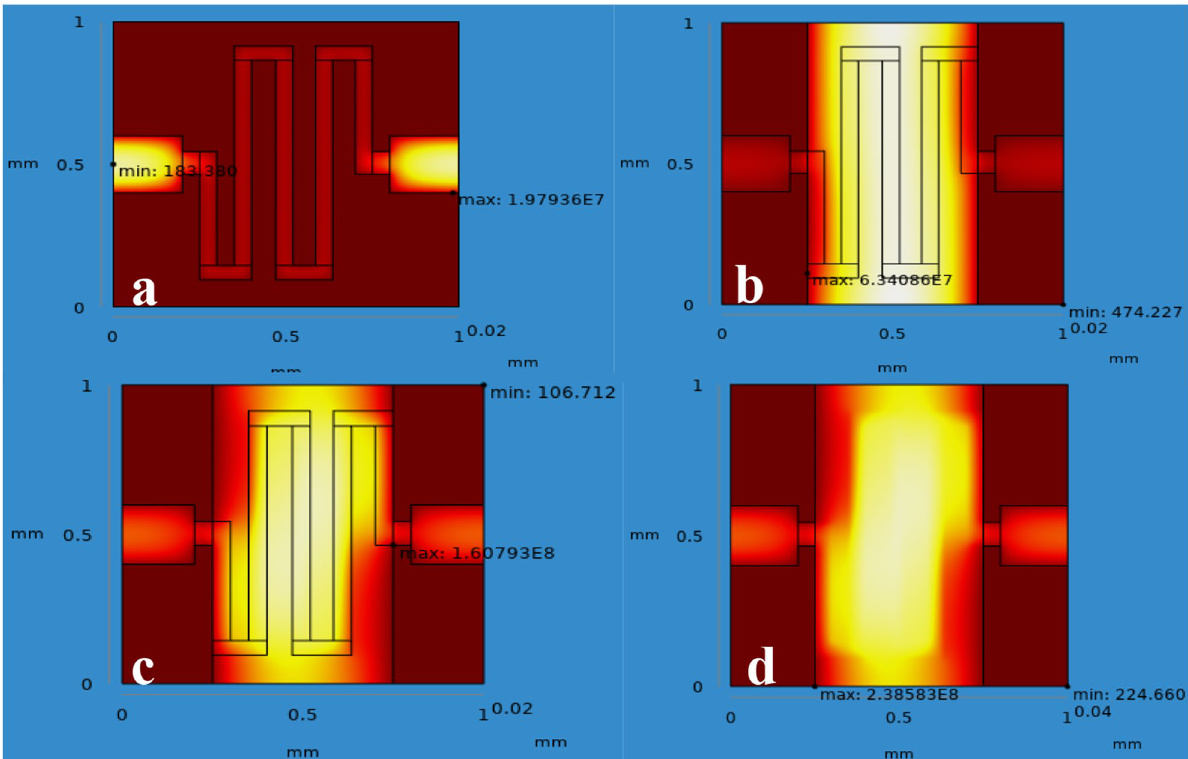
Figure 9. Temperature distribution on sensing layer of the chemical gas sensor: ( a ) SnO 2 , ( b ) SnO 2 –Pd, ( c ) SnO 2 –rGO and ( d ) SnO 2